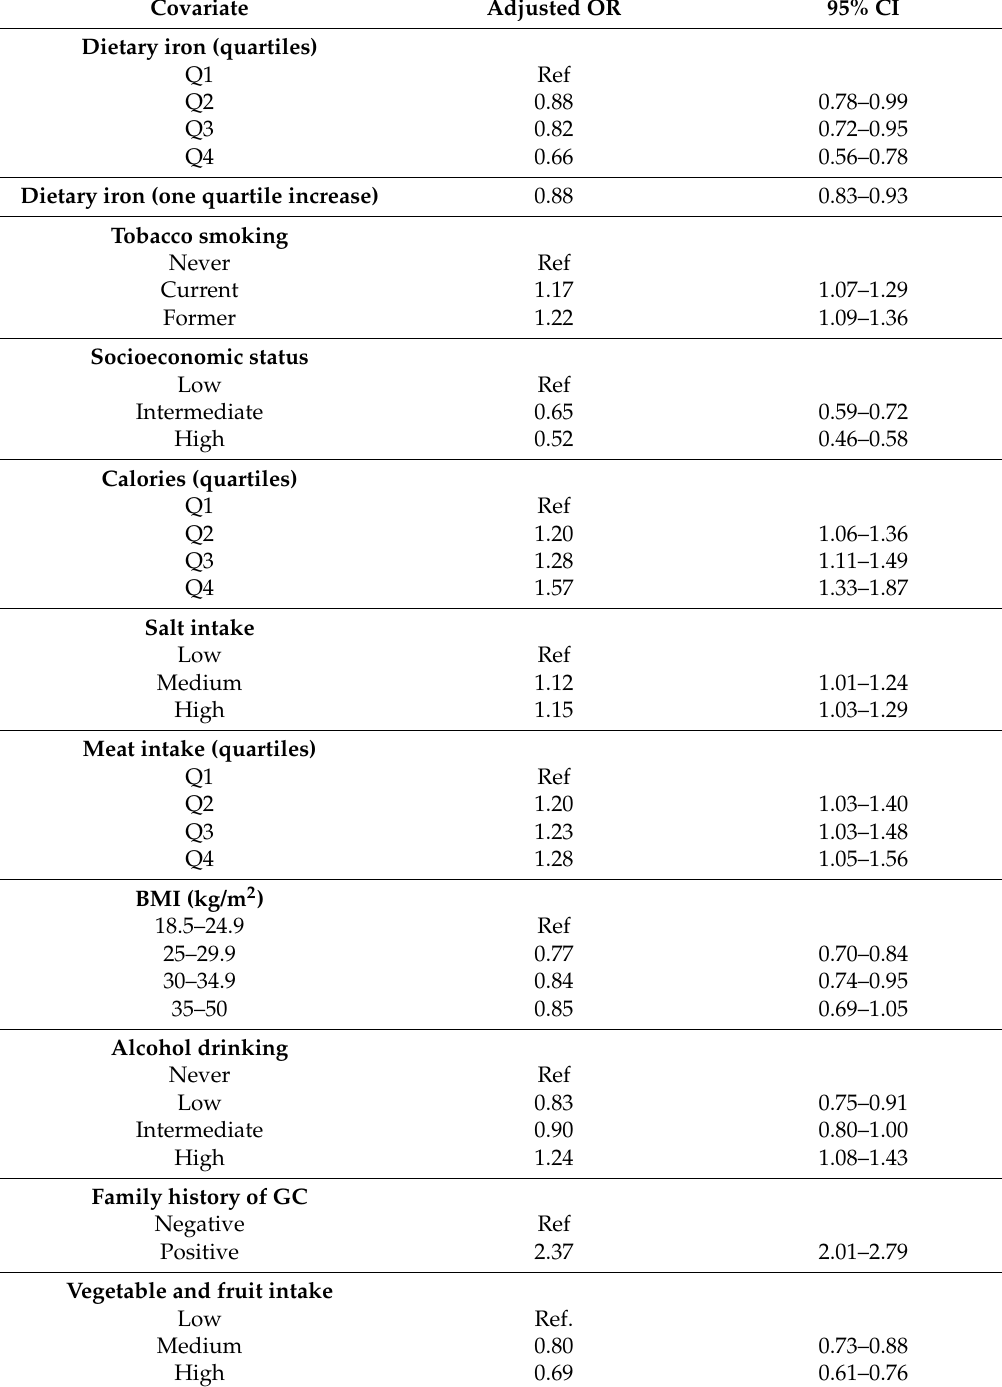
Table 2. Adjusted odds ratios and 95% confidence intervals of the association between dietary iron intake and other selected characteristics and gastric